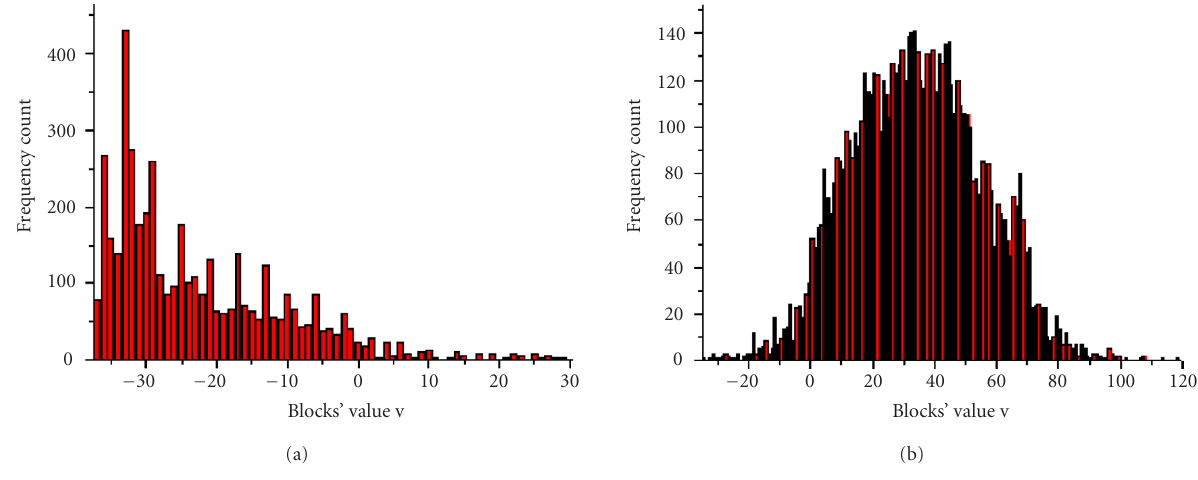
Figure 25: The value of the (a) background and (b) foreground class in linear classification in FVC2002